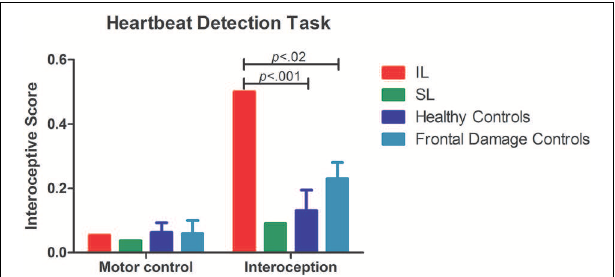
FIGURE 3 | Internal stream: HBD task. Results of the accuracy in the HBD task. Left side of the panel shows the motor control condition, where no differences where observed given that all participants performed the task accurately. The right side of the panel shows the performance on interoceptive sensitivity, where the IL patient exhibited impaired interoception. Conversely, the SL patient was